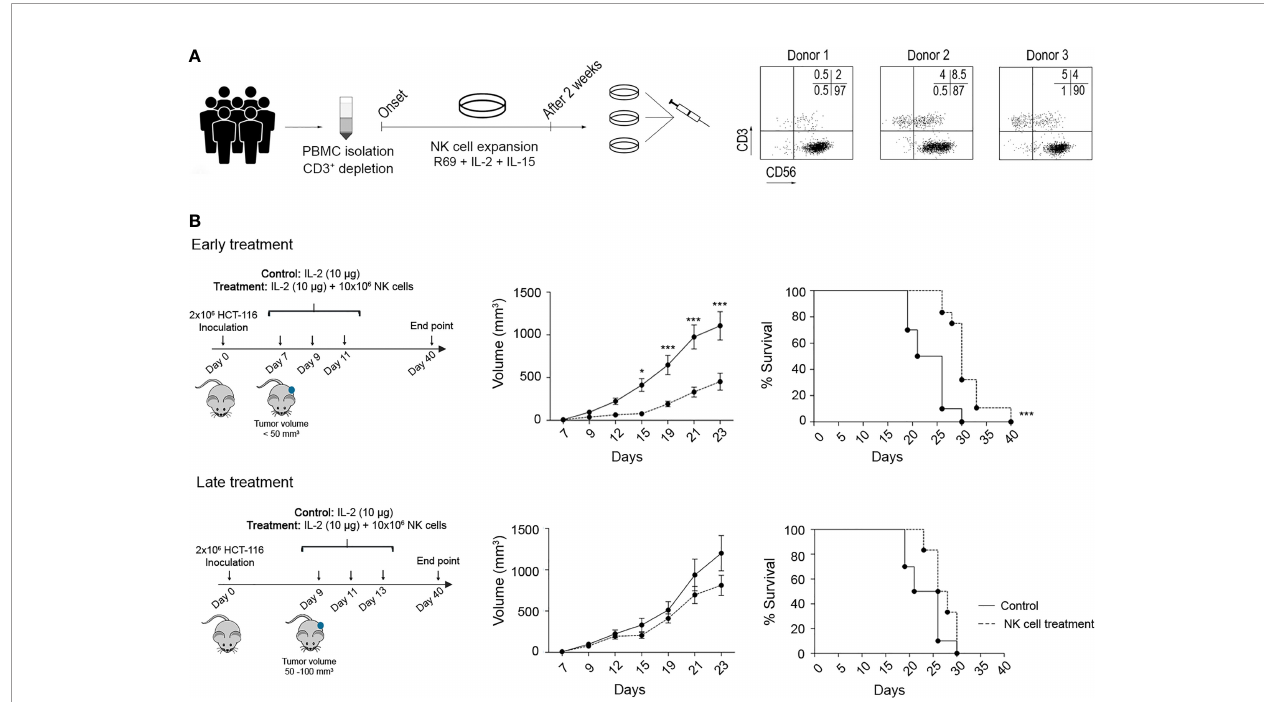
FIGURE 5 | Ef fi cacy of adoptive NK cell transfer against CRC tumours in a xenograft model. (A) NK cell expansion protocol for adoptive transfer. PBMCs derived from six HDs were depleted from the CD3 + population and expanded for 14 days with LCL-EVB+R69 feeder cells (1:10 feeder:NK cells), IL-2 (100 UI/ml), and IL-15 (5 ng/ml). The NK cell purity for each donor was analysed by fl ow cytometry before preparing a pool of NK cells combining 3 different cell cultures. (B) Ef fi cacy of activated NK cells against HCT-116 tumours after an early or a late treatment. On day 0, NSG mice were inoculated with 2 × 10 6 HCT-116 cells. After 5 (early treatment) or 7 (late treatment) days, mice were i.p. inoculated with vehicle (RPMI and 10 µg/mouse IL-2) or treatment (10 7 NK cells and 10 µg/mouse IL-2). Tumour development was monitored over 40 days as described in Material and Methods . Data are presented as mean ± SEM of 10 mice in 2 independent experiments for control and early treatment groups, and 6 mice in 1 experiment for late treatment group. Statistical analyses to compare tumour volume curves were performed by two-way ANOVA test with Bonferroni ’ s post-test. Survival curves were analysed with Log-rank (Mantel – Cox) test. ∗ p < 0.05; ∗∗∗ p < 0.001. CRC, colorectal cancer; PBMCs, peripheral blood mononuclear cells; HDs, healthy donors; RPMI, Roswell Park Memorial